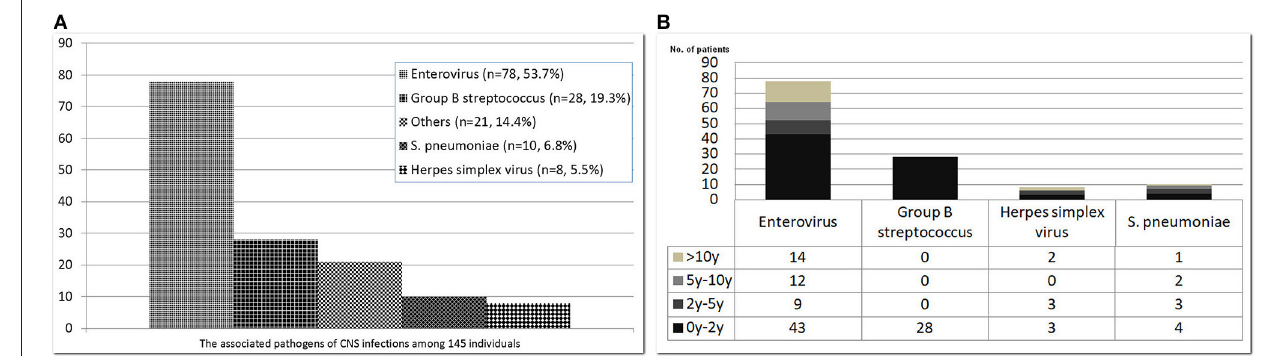
FIGURE 2 | Common pathogens of central nervous system infections among 145 affected subjects (A) and their stratification by age (B) . The pathogenic organisms of “others” included Adenovirus ( n = 2), HHV-6 ( n = 2), HHV-7 ( n = 1), Parvovirus ( n = 1), Varicella-zoster virus (n = 1), Citrobacter koseri (n = 1), Enterobacter